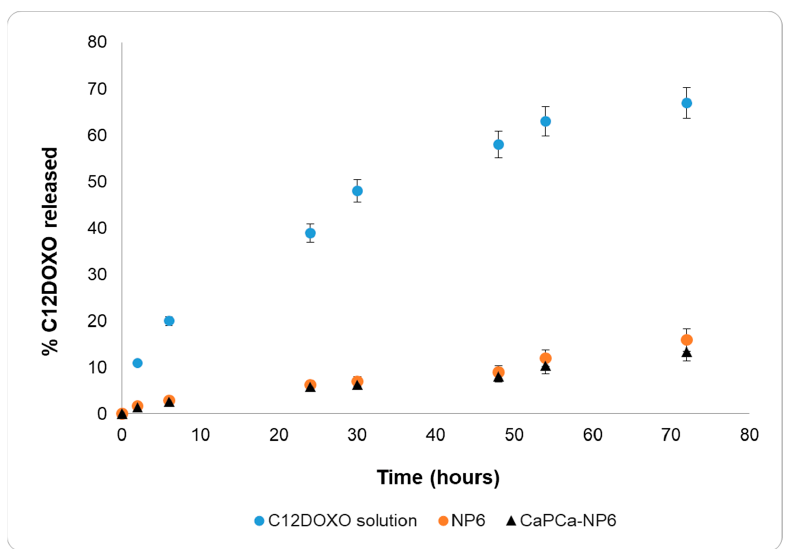
Figure 2. C12DOXO release profiles from 0.1% w / w Tween ® 80 aqueous solution, NP6, and CaP Ca - NP6.